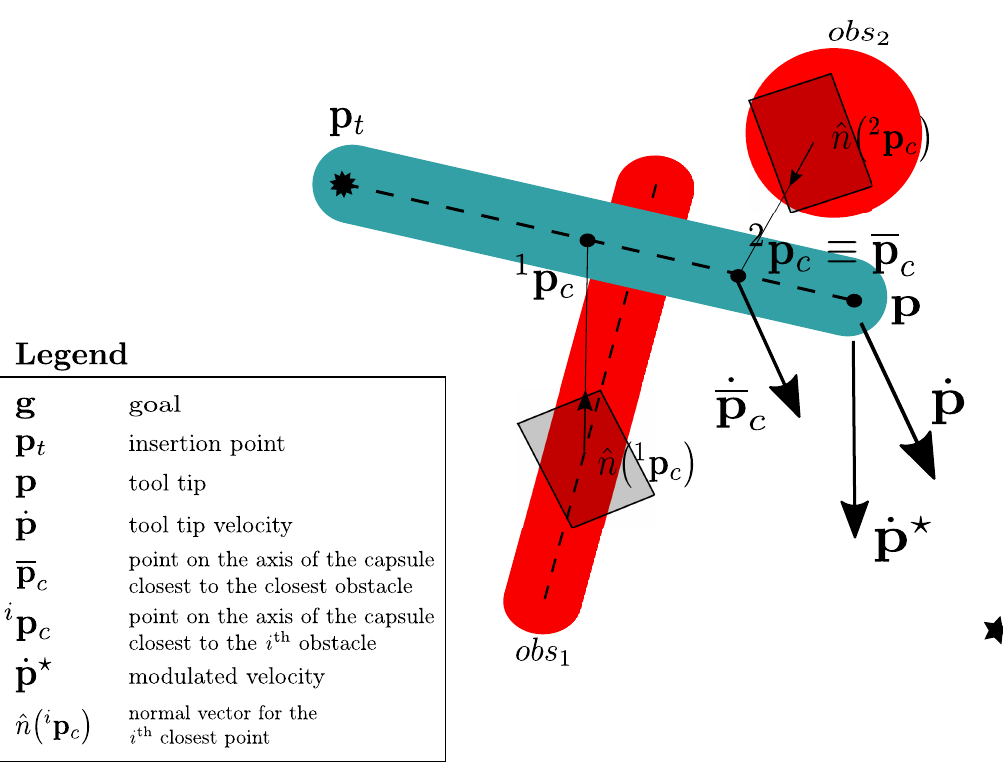
Figure 1. In blue: the controlled tool modeled as a capsule. In red: a spherical obstacle and a capsule-shaped obstacle.